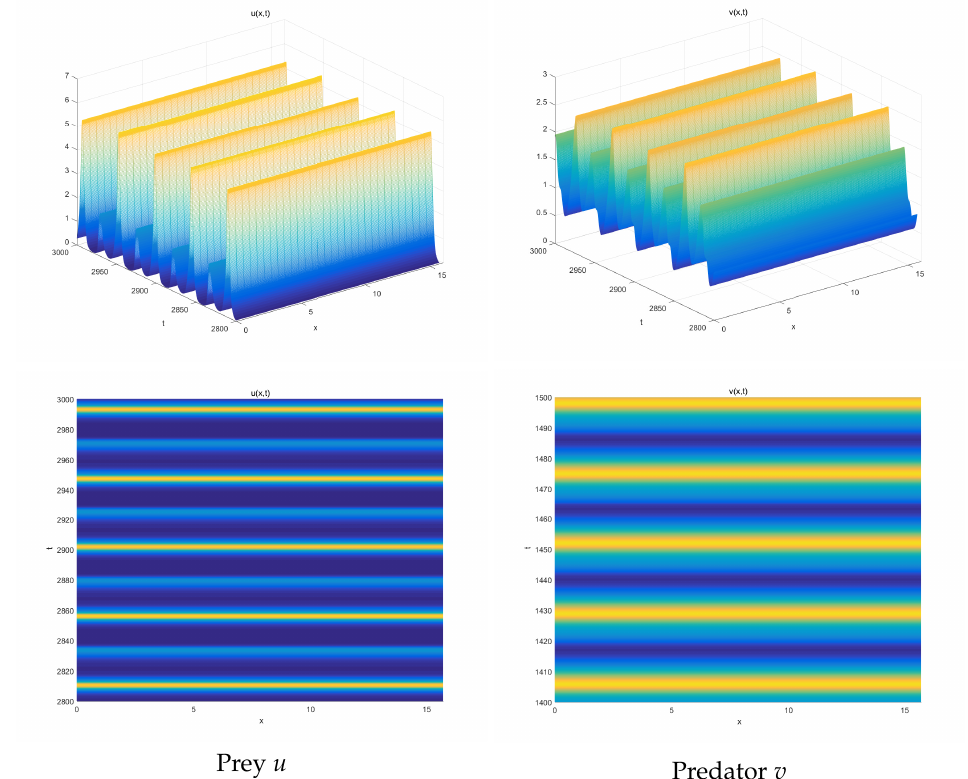
Figure 4. The numerical simulations of system (3) with τ = 1.5 and other parameters is given by